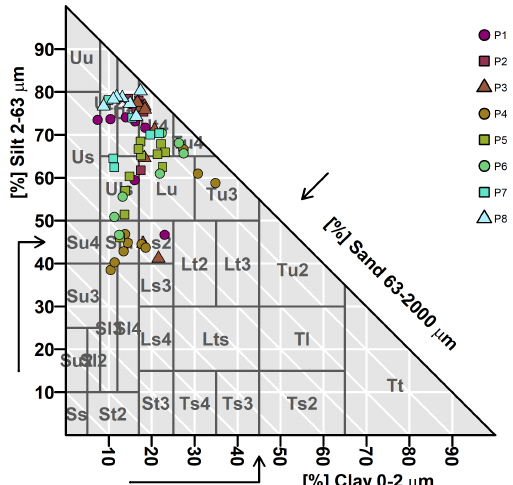
Figure 8. Soil textural classification according to the German Bo- denkundliche Kartieranleitung (Ad-hoc-AG Boden, 2005) grouped by soil profiles (P1 to P8). Ss: pure sand; Su2: slightly silty sand;